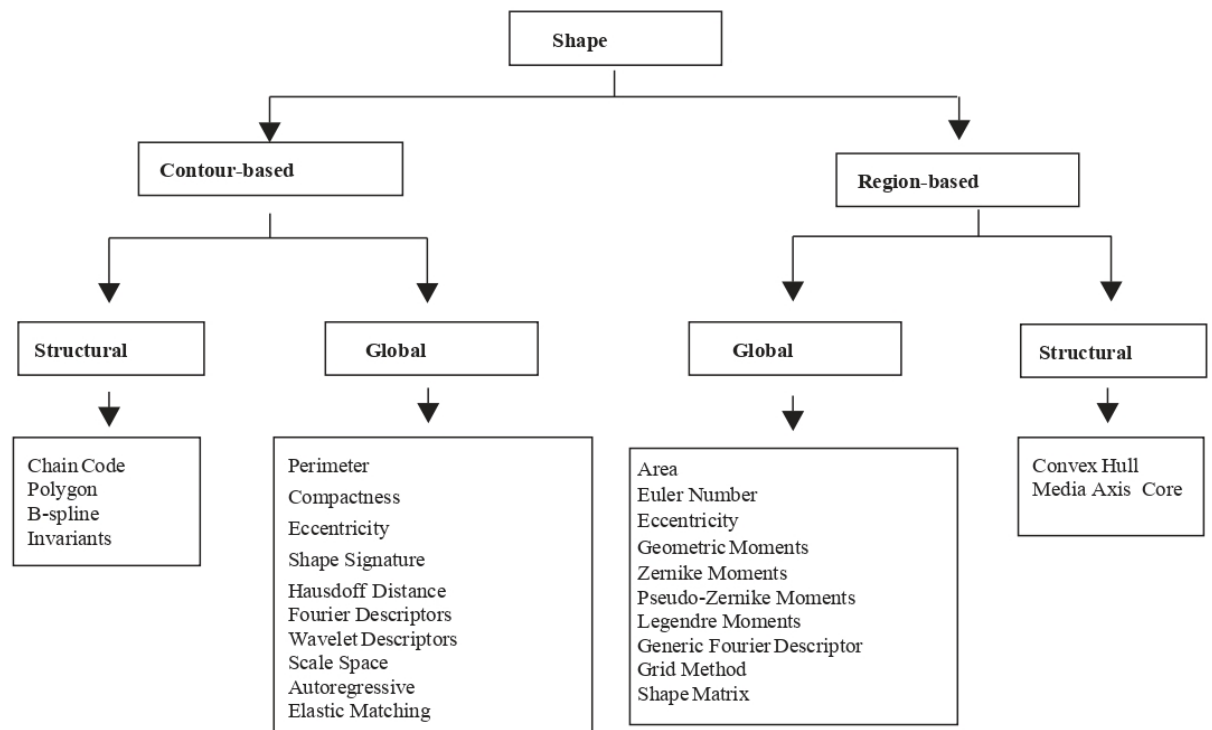
Figure 1. T ypology of shape description and representation techniques [19]. Figure 1. Typology of shape description and representation techniques